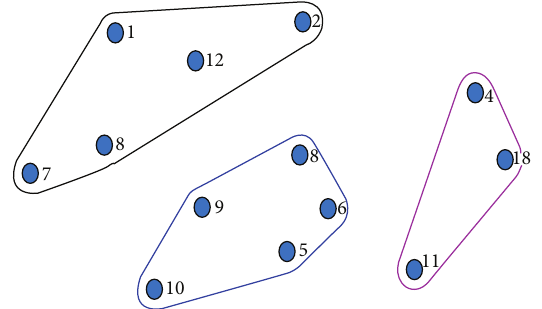
Figure 2: Cluster analysis of perceived reasons of low